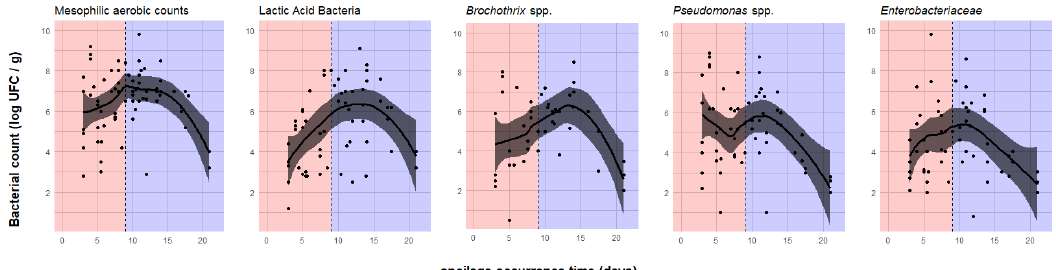
Figure 9. Enumeration of different microbiological indicators observed at spoilage occurrence times. The dotted vertical line corresponds to the median spoilage occurrence time characterizing early and belated spoilage stages, which are represented in red and blue backgrounds, respectively. The thick black curve represents the smooth curve obtained by LOESS local non-linear regression. The grey band corresponds to the 95% confidence interval around the smooth curve.